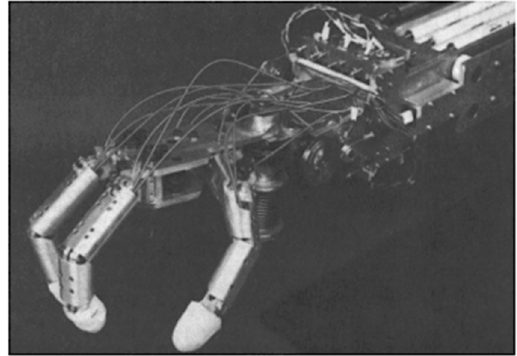
Figure 2. The Hitachi’s robot hand [14] .